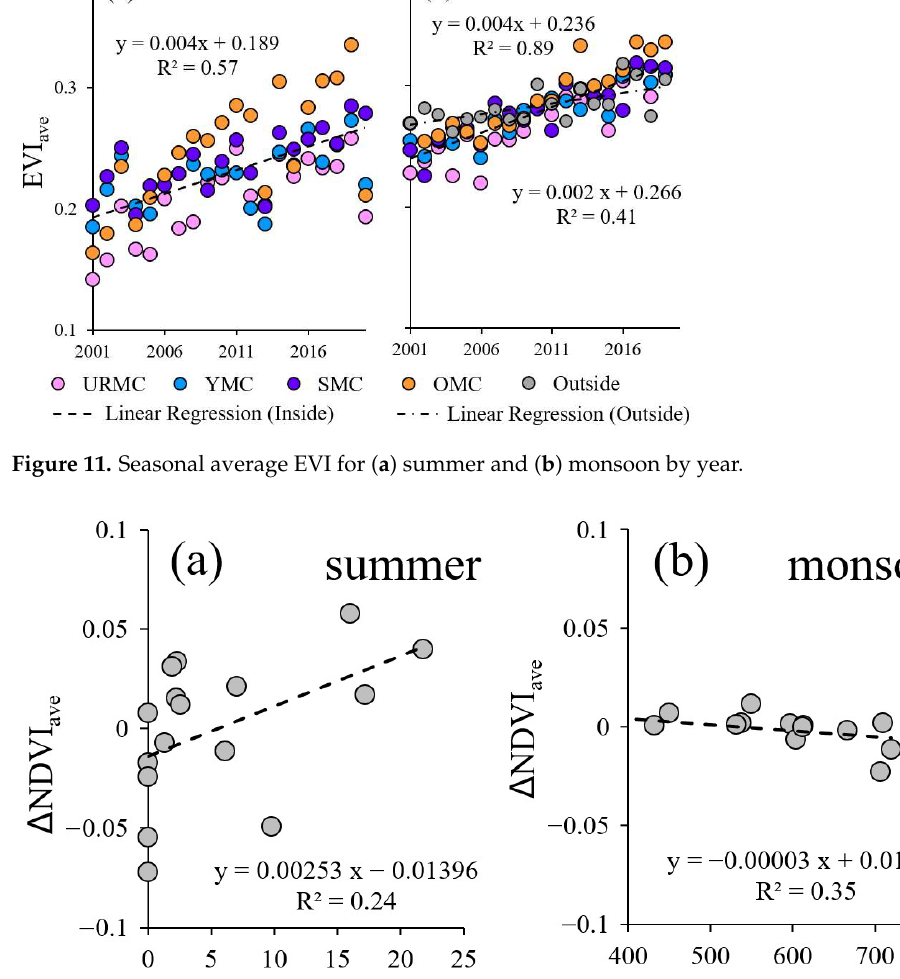
Figure 11. Seasonal average EVI for ( a ) summer and ( b ) monsoon by year.